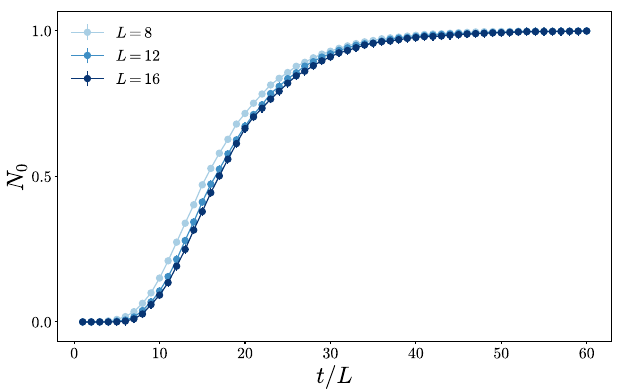
FIG. 13. Dynamics of charge sharpening in qubit chains. Fraction of trajectories with δ Q 2 < ϵ with ϵ ¼ 10 − 3 at p ¼ 0 . 085 , inside the fuzzy